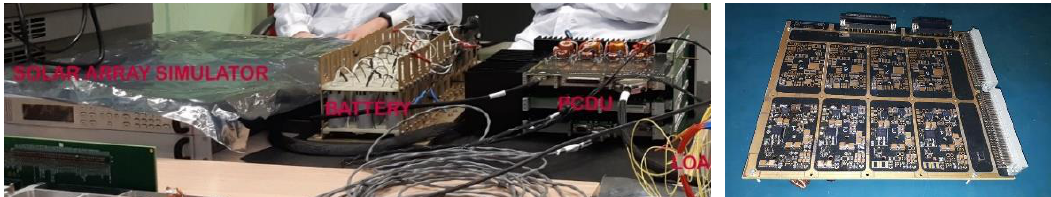
Figure 15. The test setup ( left ): the breadboard PCDU is supplied by a Keysight E4360 Solar Array Simulator and drives a power bus connected to a 4P9S Li-ion battery and to the loads. The converter board of the PCDU ( right ), designed to accommodate up to eight